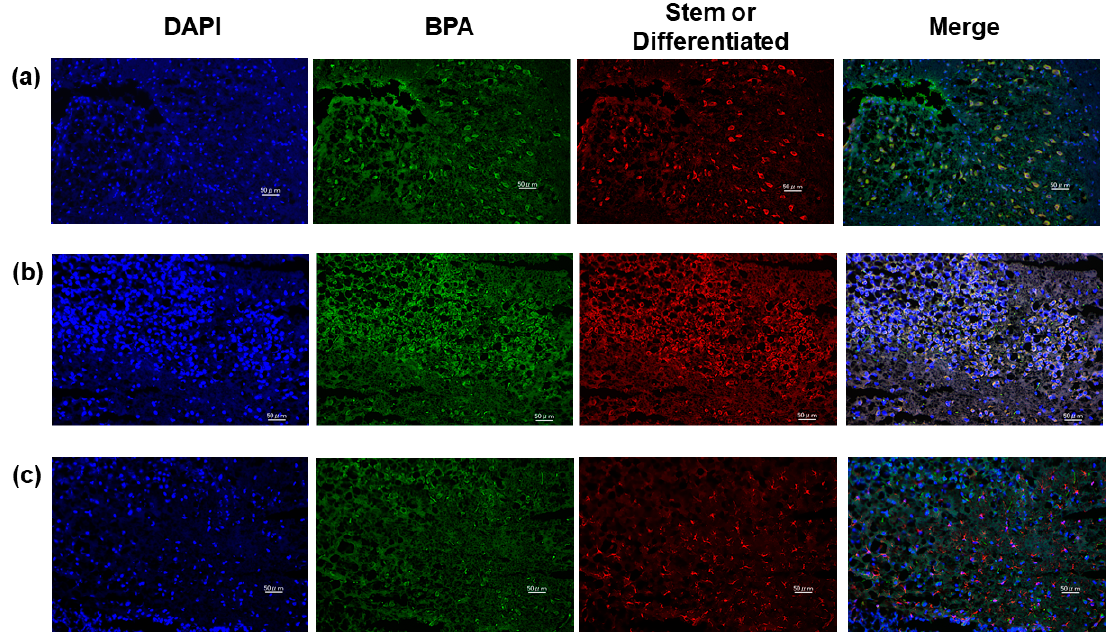
Figure 2. Relationships among proliferation marker Ki-67, stem markers and BPA uptake. ( a ) Total stem and differentiated cells (DC) from no. 1 cells and expressions of ( b.1 ) SOX2 and ( c.1 ) PDGFR α in no. 1 stem-like cells; ( d ) total stem and DC from no. 2 cells and expressions of ( e.1 ) SOX2 and ( f.1 ) STAT3 in no. 2 stem-like cells. Percentages in ( b.2 – 5 ), ( c.2 – 5 ), ( e.2 – 5 ) and ( f.2 – 5 ) indicate BPA + cells for each stem marker + or stem marker − /Ki-67 + or Ki-67 − populations.